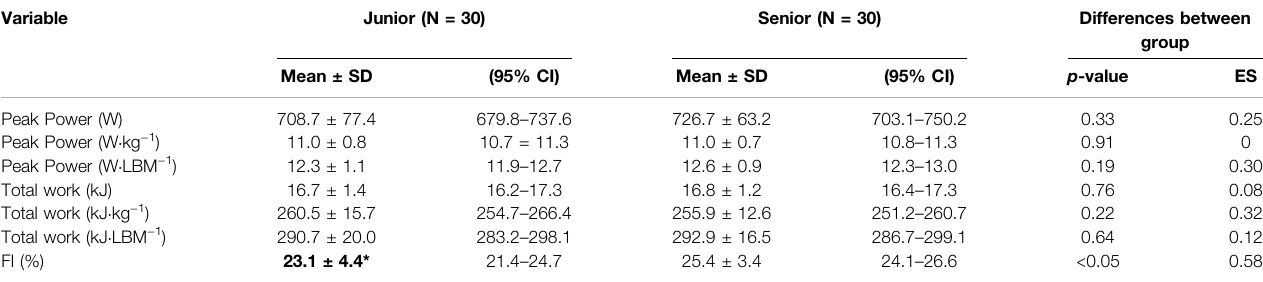
TABLE 3 | Mean ± standard deviation and 95% CI of anaerobic performance determined in the Wingate